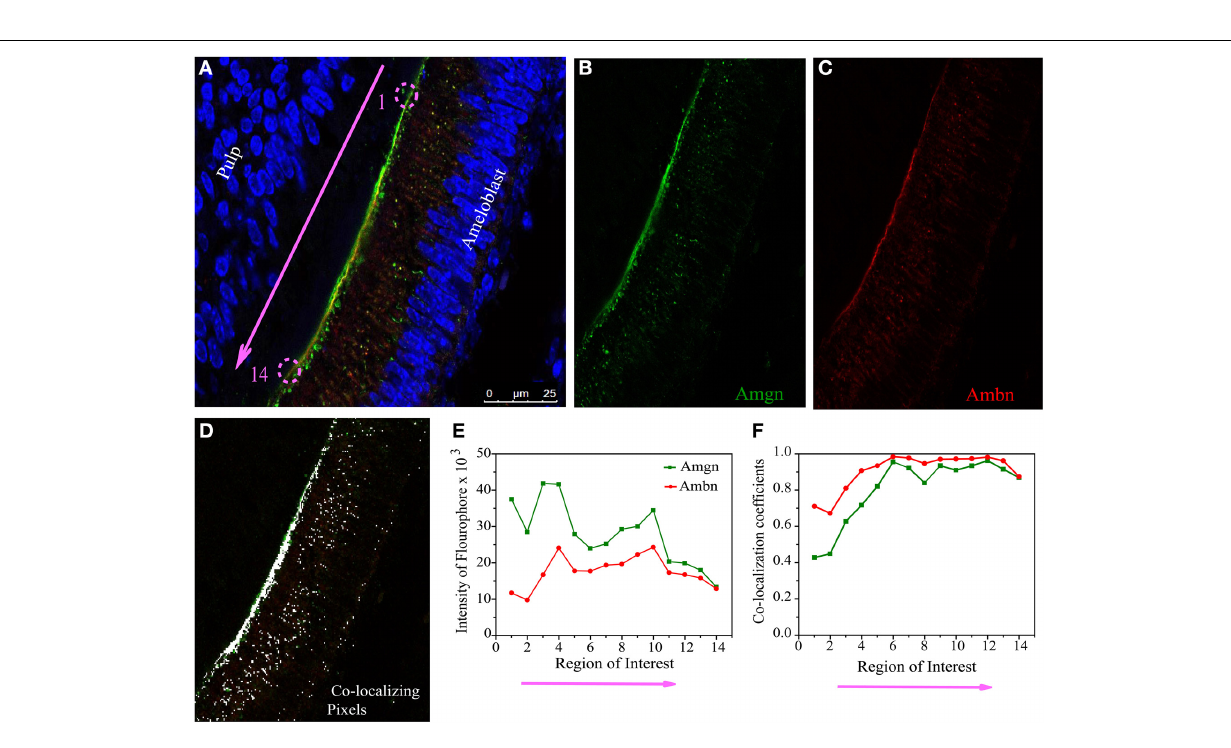
the pixels that have only co-localizing signal after threshold and background corrections of image (A) . (E) Graph of total intensity sum of each fluophore. (F) Plot of Mander’s co-localization coefficient with respect to region of interest as shown in (D) . Each ROI dimension (5 × 5 μ m). Note that ROI 1 to 14 in (E,F) correspond to the pink arrow in (A)